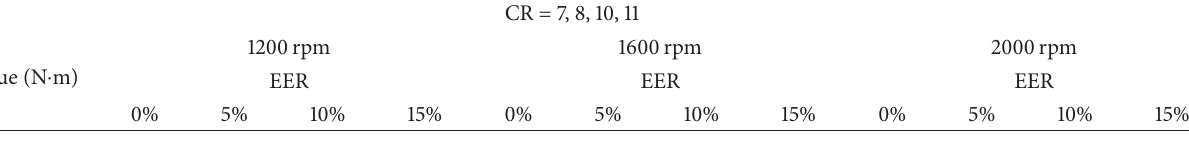
Table 3: The experimental program.